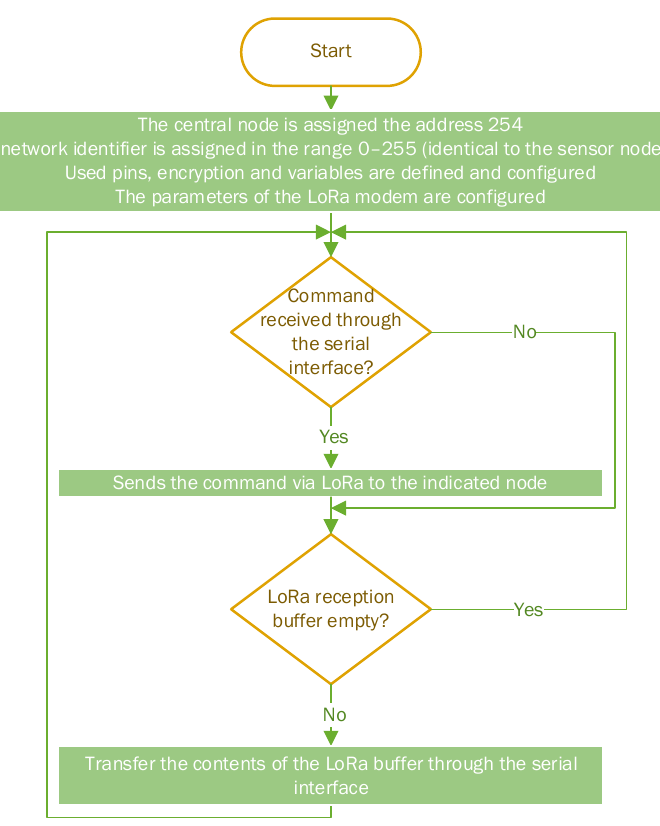
Figure 7. C entral node program flowchart. Figure 7. Central node program